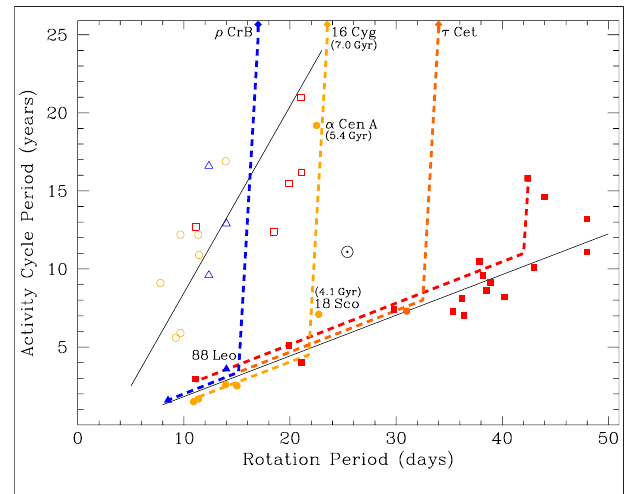
FIGURE 6 | Stellar activity cycle length vs. rotation period for stars with measured cycles. The solid lines denote two different sequences that had been studied before Kepler , with the Sun ( ⊙ ) being a perplexing outlier (or midlier). Symbols are colored by spectral type, F (blue triangles), early G (yellow circles), late G (orange circles), and K (red squares). The dashed lines are schematic evolutionary tracks, which advance in time to the right and upwards. Some well known stars are labeled. Adapted from Metcalfe et al. (Metcalfe et al.,